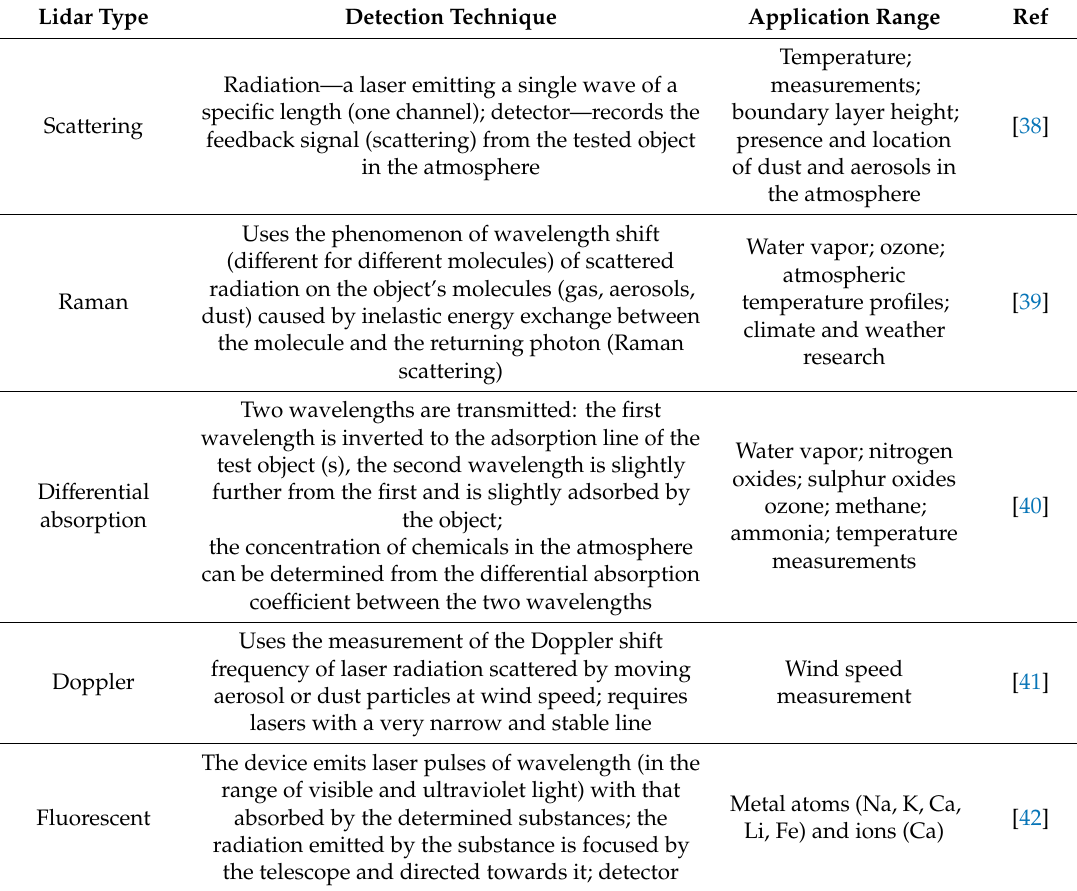
Table 1. List of technologies used in lidars to perform various measurements necessary in air monitoring. Lidar